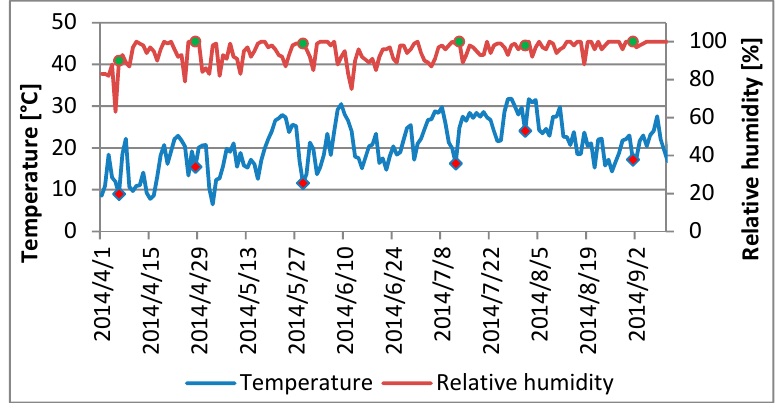
Figure 8. Time course of temperature and relative humidity in 2014 (Belsk station) together with indicators of days when the relative value of the prediction was >50%.